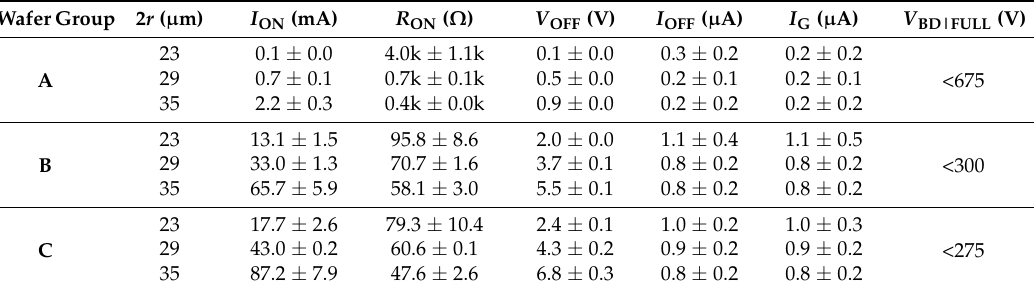
Table 1. Measured values for the main Figures of